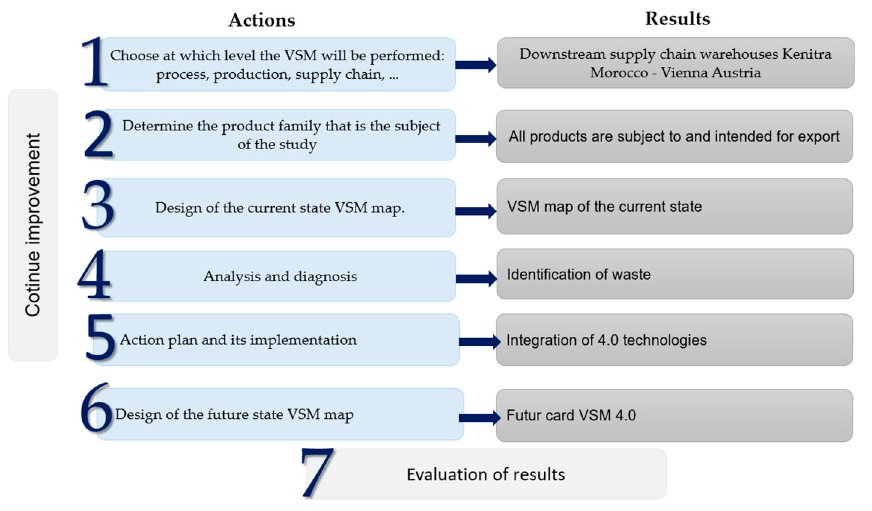
Figure 3. VSM design process.